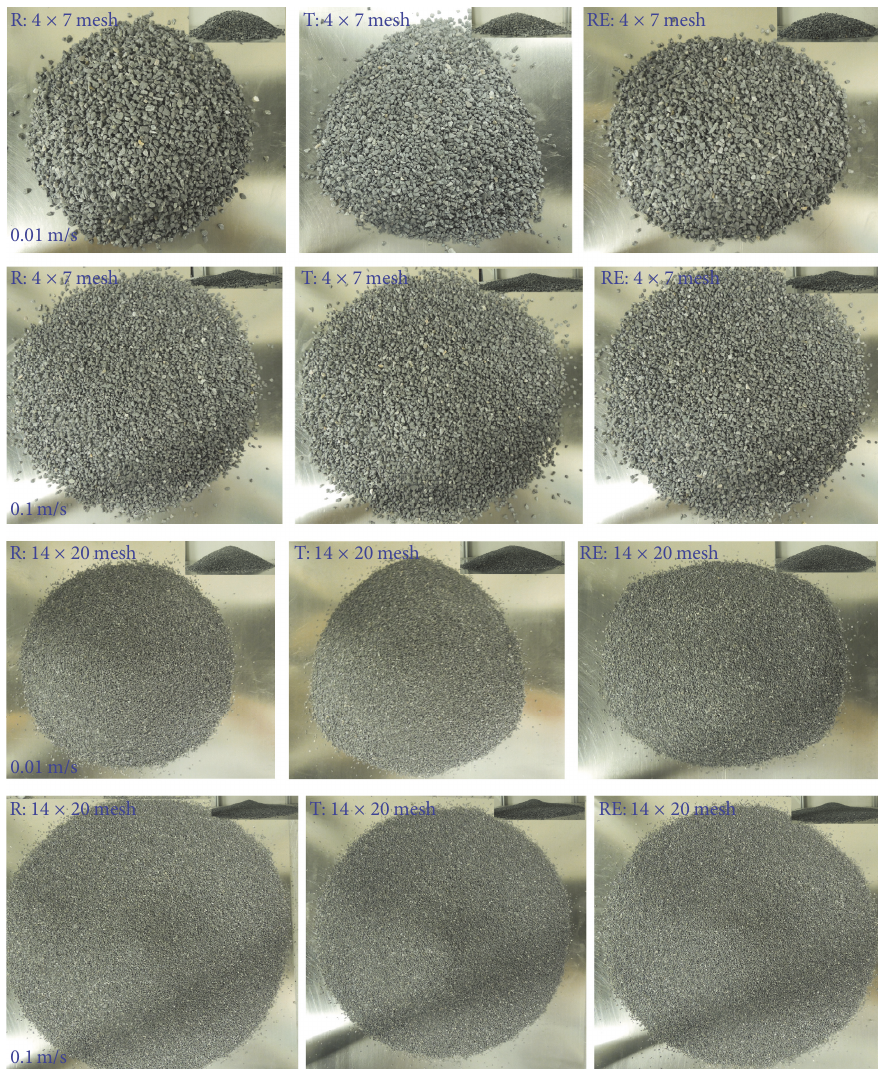
Figure 7: The sand-piles formation (4 × 7mesh and 14 × 20 mesh) at the velocity of 0.01 m/s and